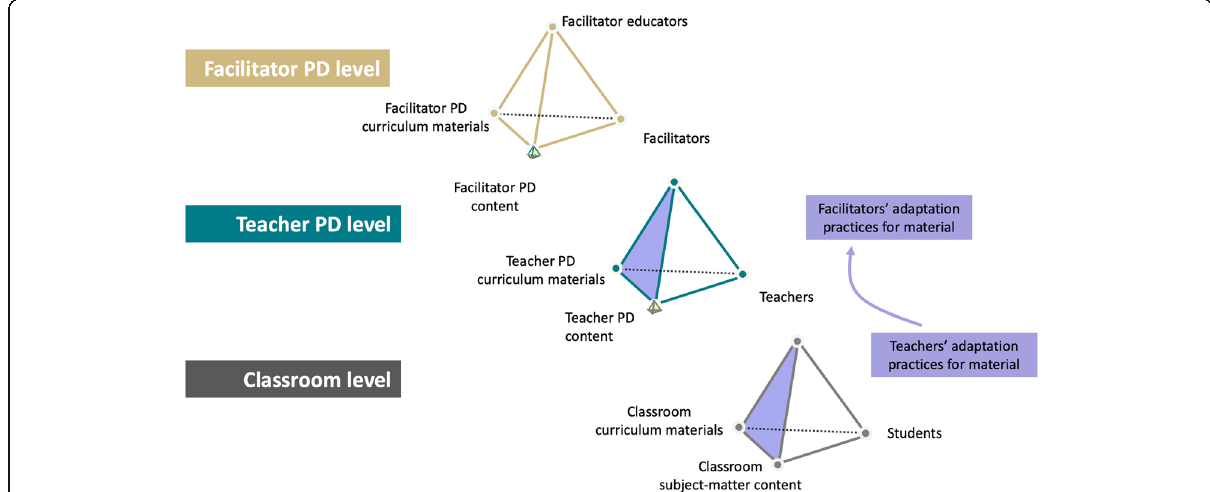
Fig. 1 Lifting the research focus on adaptation practices from teachers ’ practices on the classroom level to facilitators ’ practices on the teacher PD